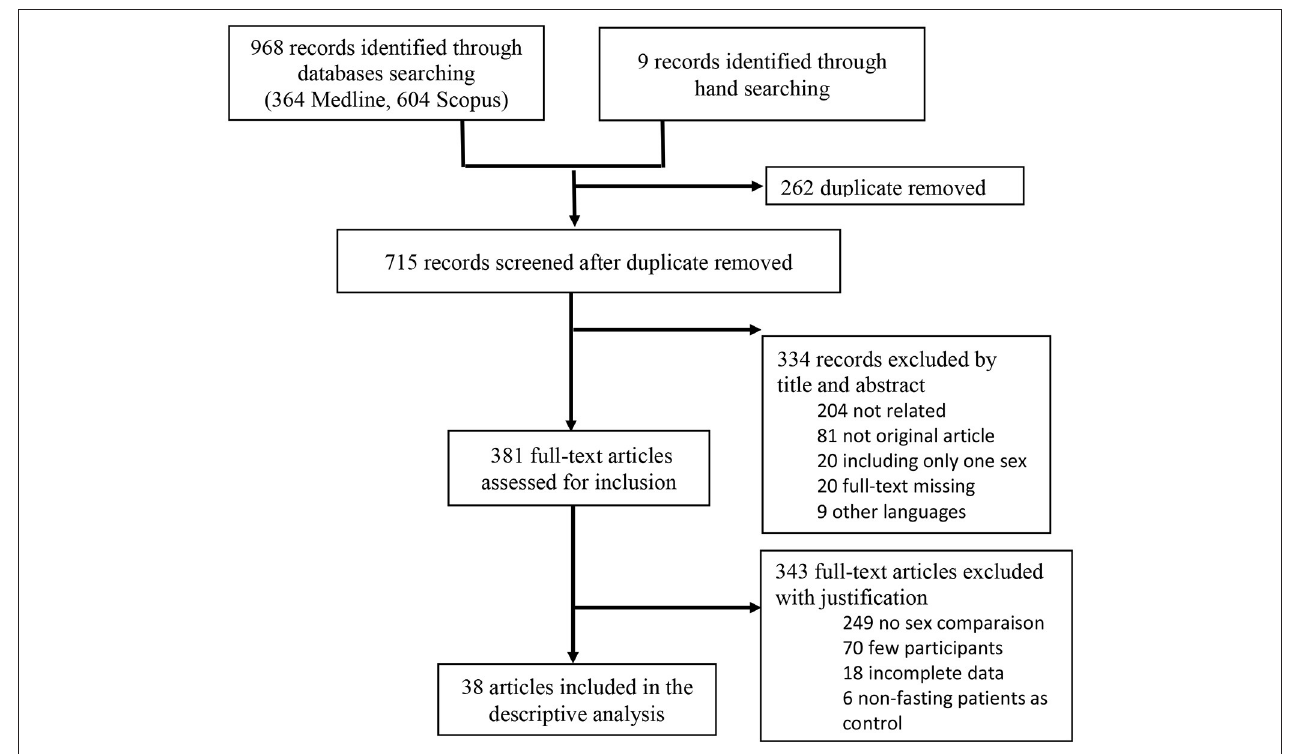
FIGURE 1 | The flow chart with the different phases of the systematic review according to the PRISMA statement.